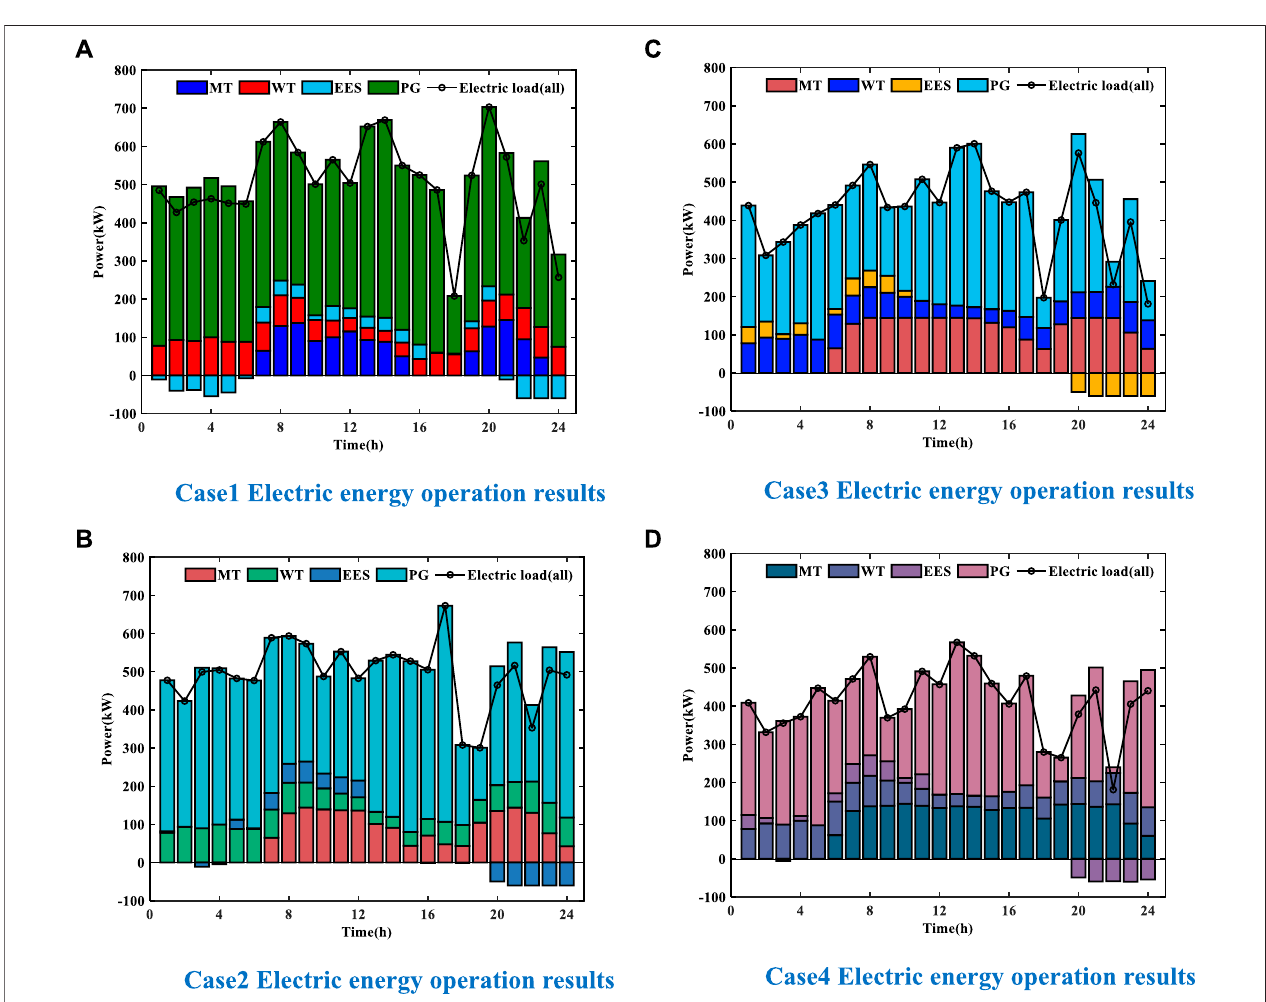
FIGURE 4 | Case1 – 4 electric energy operation results. (A) Case1 electric energy operation results. (B) Case2 electric energy operation results. (C) Case3 electric energy operation results. (D) Case4 electric energy operation results.